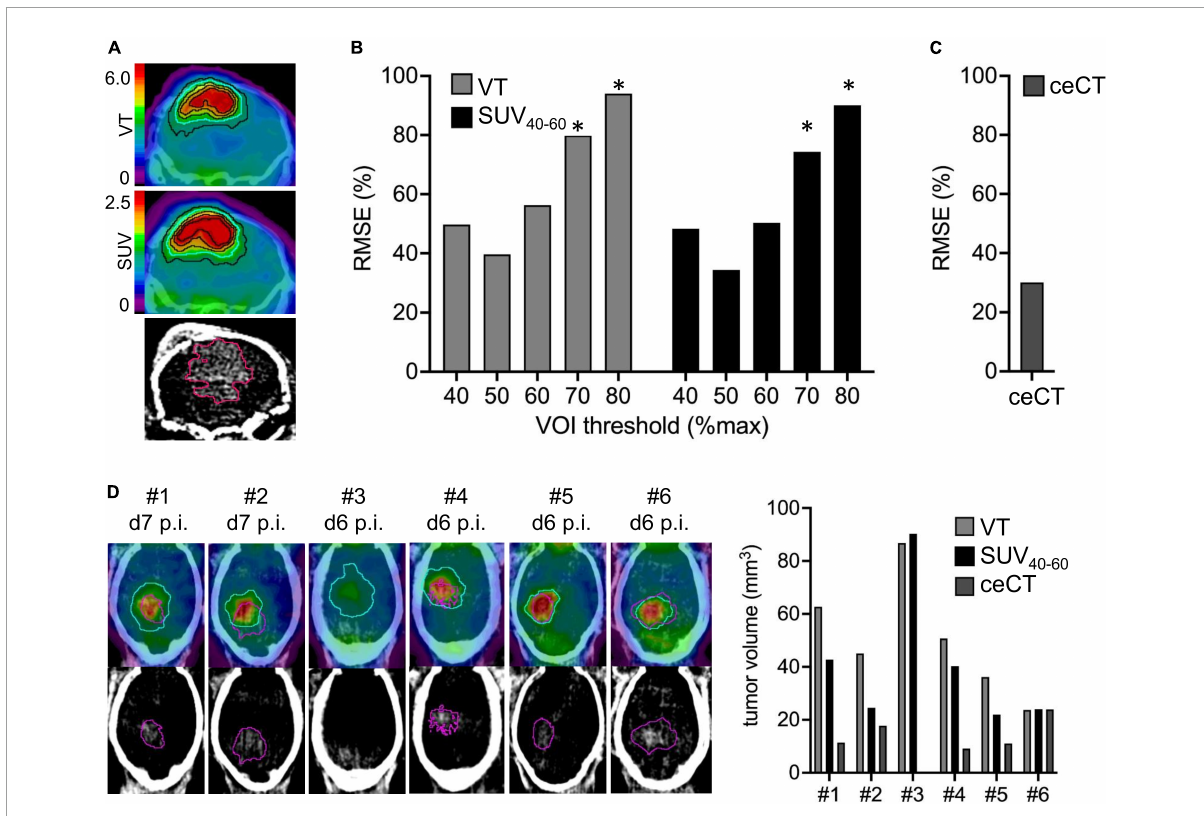
FIGURE2 Assessment of lesion volumes by TSPO-PET and contrast enhanced CT (ceCT). (A) TSPO-PET and ceCT images illustrate lesion volume definition for a SB28 tumor at week-3. Isocontours represent different %max thresholds (blue = 50%) of TSPO-PET and the 30HU ceCT threshold. PET derived lesion volumes with different thresholds (B) and ceCT lesion volumes (C) were compared to standard-of-truth ex vivo tumor volume assessment in week-3 SB28 mice by calculation of root-mean-square-errors (RMSE%). (D) Direct comparison of lesion volume assessment between PET and ceCT in week-1 SB28 mice ( n = 6). Axial slices show TSPO-PET VT and ceCT. The determined optimal 50% PET threshold (blue) was used for assessment of TSPO-PET lesion volumes. The ceCT threshold is shown in purple. Mouse #3 did not indicate